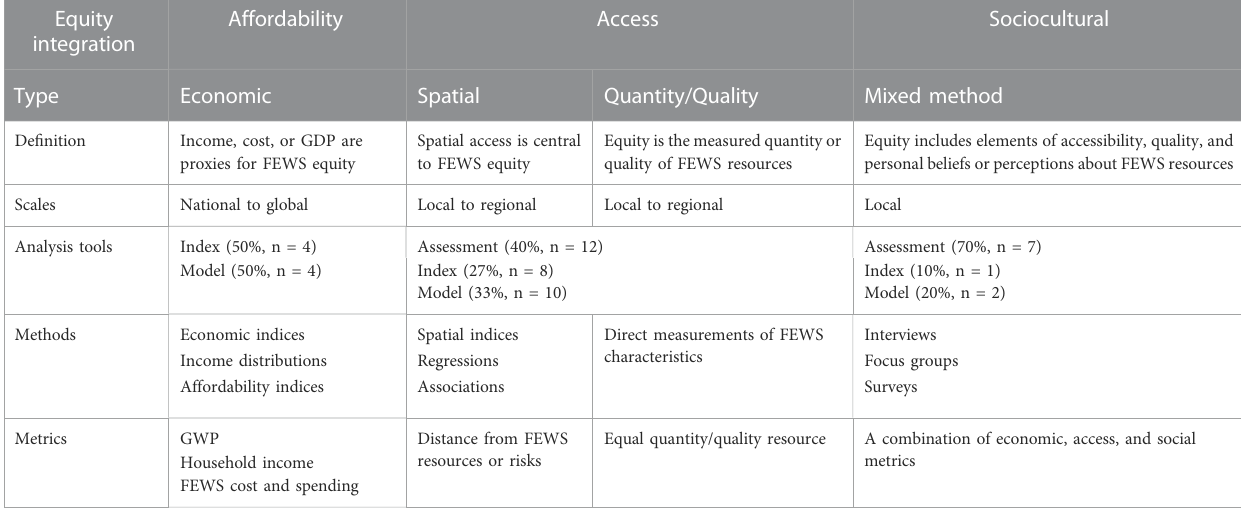
TABLE 2 Equity integration in FEWS analyses in three categories based on metrics used and characteristics of affordability, access, and sociocultural equity. The scale, tools, and metrics listed are not comprehensive but represent examples commonly